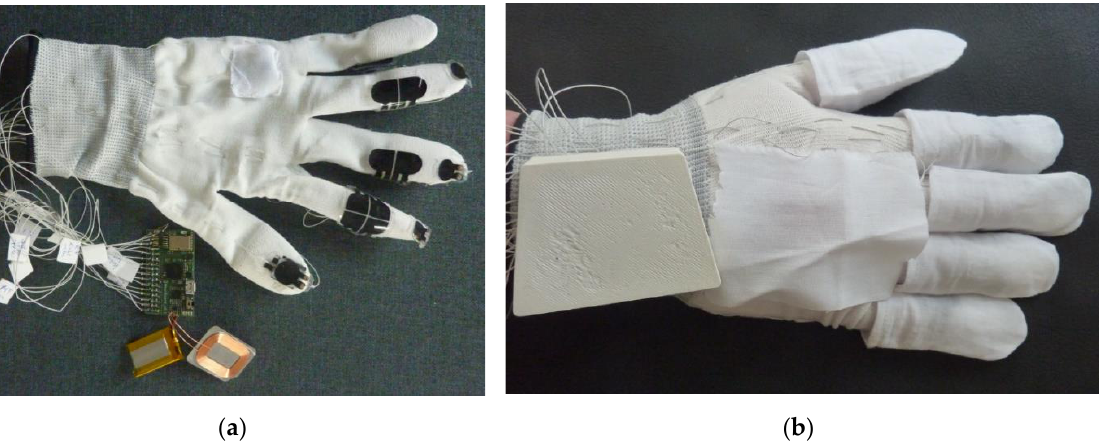
Figure 30. Operating gloves in a disassembled stage with visible sensors, two 1D and one 2D sliding sensors, a pressure sensor, several contact sensors and electronic components ( a ) and in the final stage with the electronic compartment on the wrist ( b )